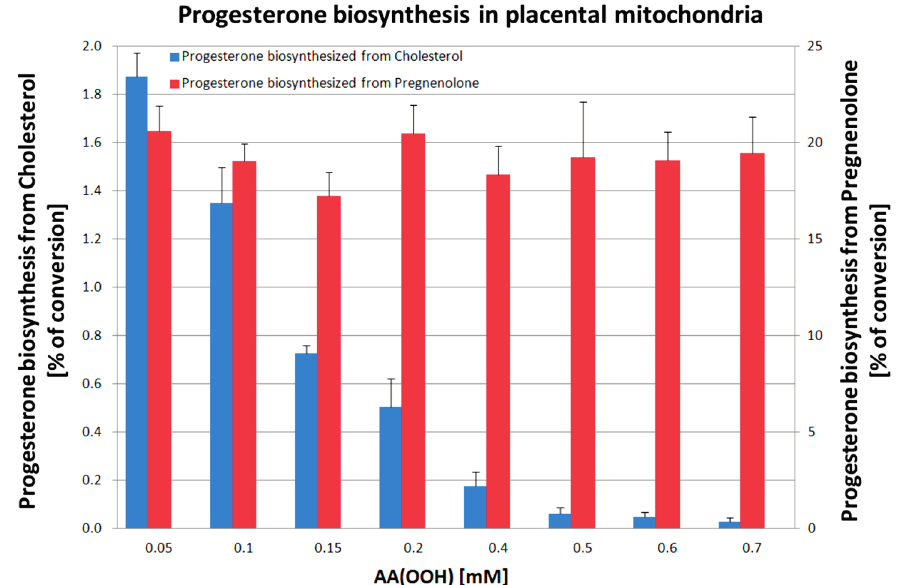
Figure 3. Progesterone biosynthesis as a function of AA(OOH) concentration in placental mitochondria (measured as percentage of substrate conversion). Progesterone biosynthesis from cholesterol or pregnenolone was measured following a 15 min. incubation. Data presented as mean ± SD obtained from five independent